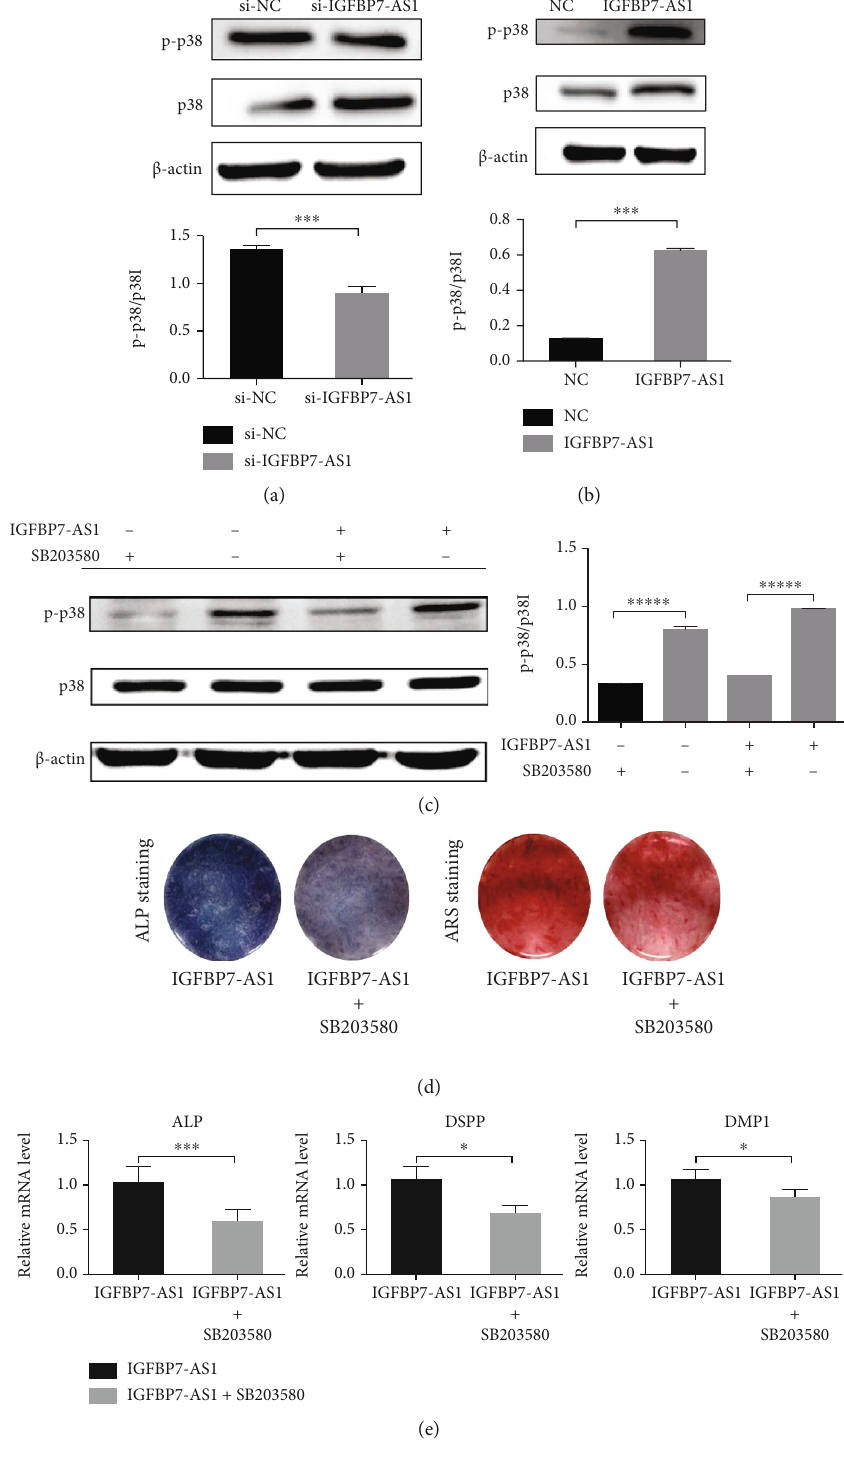
Figure 6: IGFBP7-AS1 regulates the odontogenic di ff erentiation of SHED via the p38 MAPK pathway. (a) Western blot detected the expression of p-p38 and p38 in the si-NC and si-IGFBP7-AS1 groups. The ratio of p-p38 and p38 was calculated. (b) Western blot detected the expression of p-p38 and p38 in the NC and IGFBP7-AS1 groups. (c) Western blot detected the expression of p-p38 and p38 in the NC and IGFBP7-AS1 groups after adding the inhibitor of the p38 MAPK signaling pathway. The ratio of p-p38 and p38 was calculated. (d) Images of ALP staining and ARS staining of IGFBP7-AS1 overexpressed SHED odontogenic di ff erentiation with or without SB203580. (e) qRT-PCR detected odontogenic di ff erentiation-related markers: ALP, DSPP, and DMP1 of IGFBP7-AS1 overexpressed SHED odontogenic di ff erentiation with or without SB203580. Data were expressed as the mean ± standard deviation (SD) of three experiments per group, ∗ p < 0 : 05 , ∗∗∗ p < 0 : 001 , and ∗∗∗∗ p < 0 : 0001